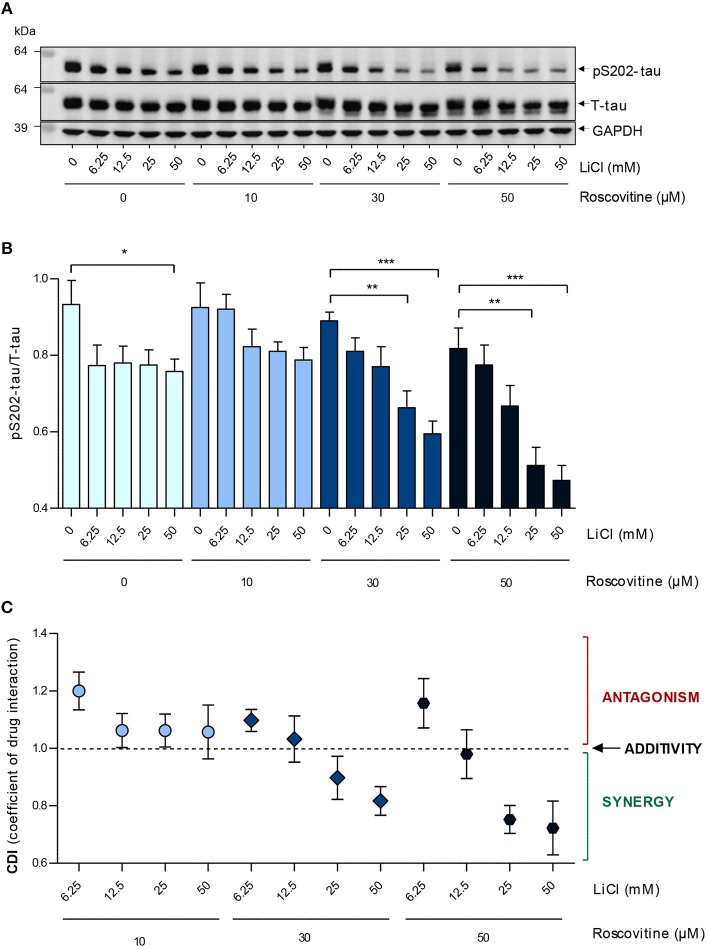
Roscovitine induces a dose-dependent down-regulation of S202-Tau phosphorylation in SH-SY5Y-(P301L) cells and synergizes with LiCl. SH-SY5Y-(P301L) cells were exposed for 6 h to a range of roscovitine and/or LiCl concentrations. Cells were harvested and proteins were resolved by SDS-PAGE followed by Western blotting (A) with pS202-tau (Mab CP13) and T-tau (Mab DA9). α-GAPDH was used as a loading control. Western blotted protein bands were quantified and normalized to GAPDH, and are presented as pS202-tau/T-tau ratios [(B), left panel, mean ± SEM of four independent experiments]. Coefficients of drug interactions (CDI) show synergistic effects at concentrations ≥25mM LiCl and 30 μM roscovitine (C). The p-values are depicted with an asterisk (*p < 0.05, **p < 0.01, ***p < 0.001; two-tailed Student's t-test).